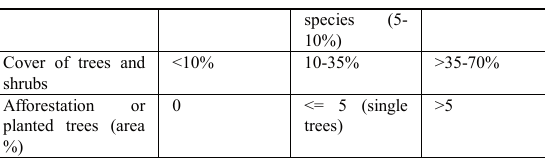
Table 1. Assessment matrix of 4030 „Dry European